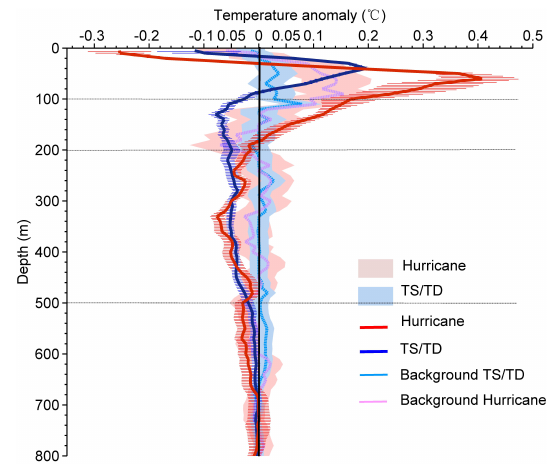
Figure 11. Vertical temperature change averaged within the − 6 to + 6 ◦ range from the storm center during the recovery stage (4– 20 days) relative to pre-storm conditions. Blue and red lines repre- sent TS/TD and hurricanes, respectively. Also plotted are the 90% confidence intervals in the null-hypothesis test (light blue and light pink shading for TS/TD and hurricanes, respectively). The light blue and pink curves show the mean background noise in TS/TD and hurricane subsets, respectively. The error bars represent the SDs, which are calculated by using the method as presented in Fig.